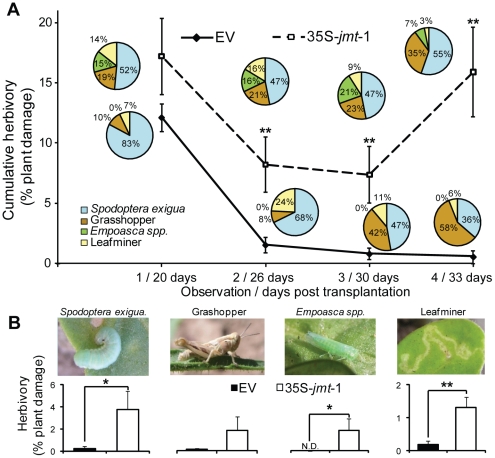
35S-jmt-1 plants are more vulnerable to herbivorous insects in nature.(A) Mean (± SD, n = 10 to 49) percentage of cumulative herbivory on 35S-jmt-1 and empty-vector (EV) transformed plants monitored 20, 26, 30 and 33 days (observations 1, 2, 3 and 4) after transplantation to the field (unpaired t-test; ** P<0.001). (B) Mean (± SD, n = 10 to 49) percentage of leaf area damaged caused by Spodoptera exigua, (3rd observation) grasshoppers (2nd observation), Empoasca spp. (3rd observation) and leaf miners (3rd observation). No significant differences were observed in the amount of damage caused by mirids (Fig. S1). Asterisks represent significant differences between EV and 35S-jmt-1 (unpaired t-test; * P<0.05; ** P<0.001).